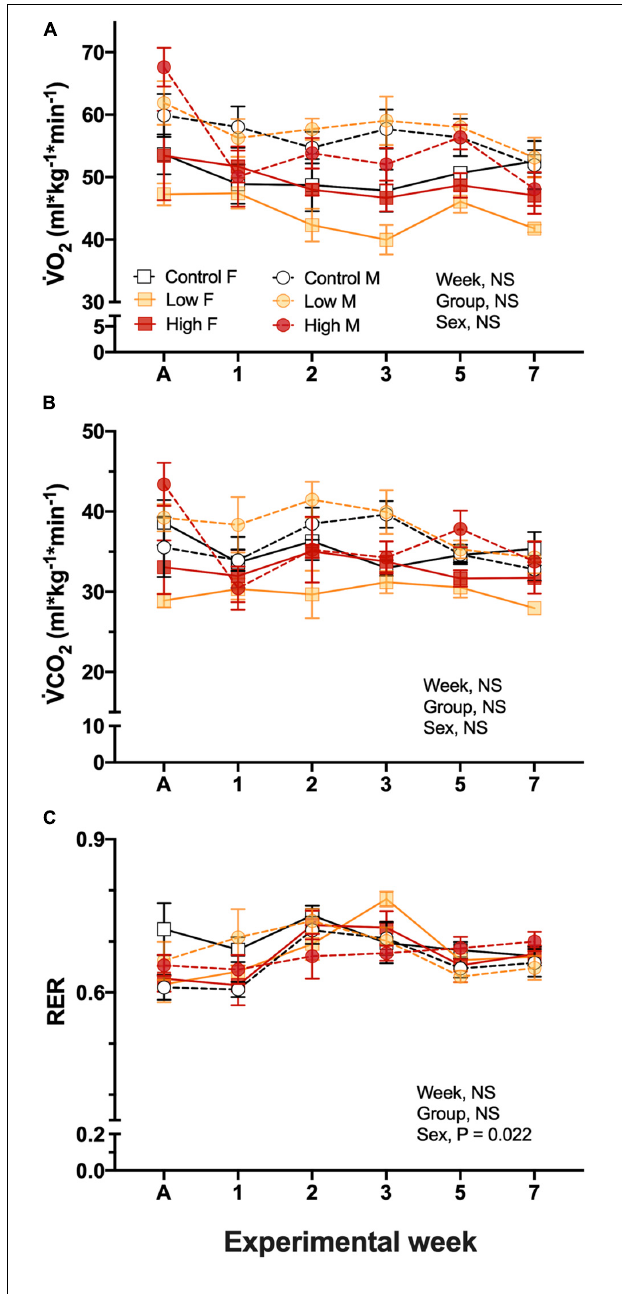
FIGURE 2 | Metabolic variables during experimentation in female (squares), and male (circles) groups of parental populations of king quail dietarily exposed to Low (1%HEWAF, light yellow symbols), High (10% HEWAF, red symbols), and Control (white symbols). (A) Oxygen consumption (˙VO 2 ), (B) Carbon dioxide production (˙VCO 2 ), and (C) Respiratory exchange ratio (RER). Data are expressed as mean ± 1 standard error of the mean. Statistical significance was considered to be α = 0.05. n = 3–5 per data